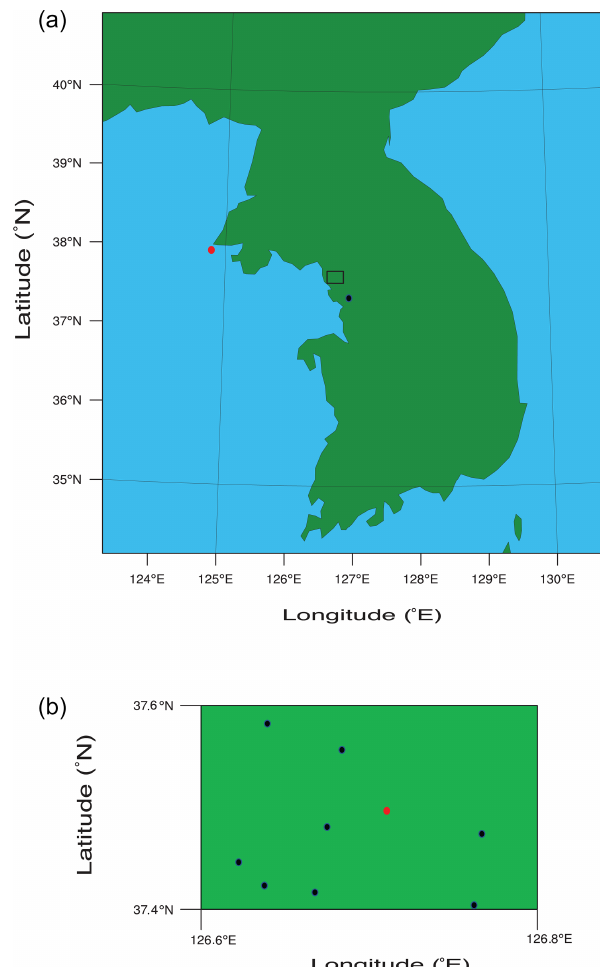
Figure 1. (a) An inner rectangle on the map of the Korean Penin- sula represents the simulation domain. The green represents the land area and the light blue the ocean area on the map. A black dot marks the location of a site where the radiosonde sounding is obtained and a red dot the location of the PM 2 . 5 station in the Yellow Sea. (b) The simulation domain is shown. The black dots mark the locations of the PM 2 . 5 stations and the red dot the location of the AERONET site in the domain.